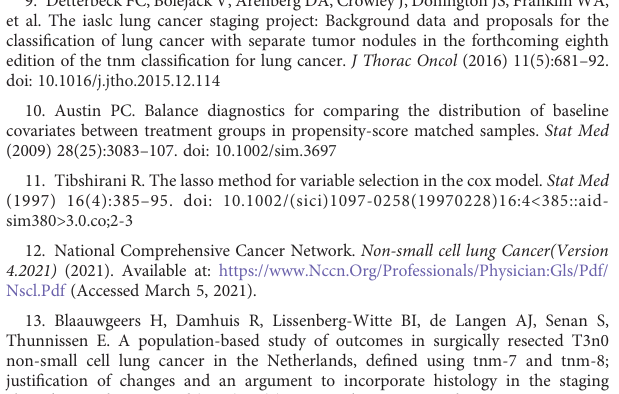
SUPPLEMENTARY FIGURE 1 Kaplan – Meier estimates of survivals in T3-Add patients strati fi ed by tumor size. (A) overall survival: T3-Add (0-30 mm) vs. T3-Add (30-50 mm) vs. T3- Add (50-70 mm) vs. T3-Add (> 50 mm); (B) cancer speci fi c survival: T3-Add